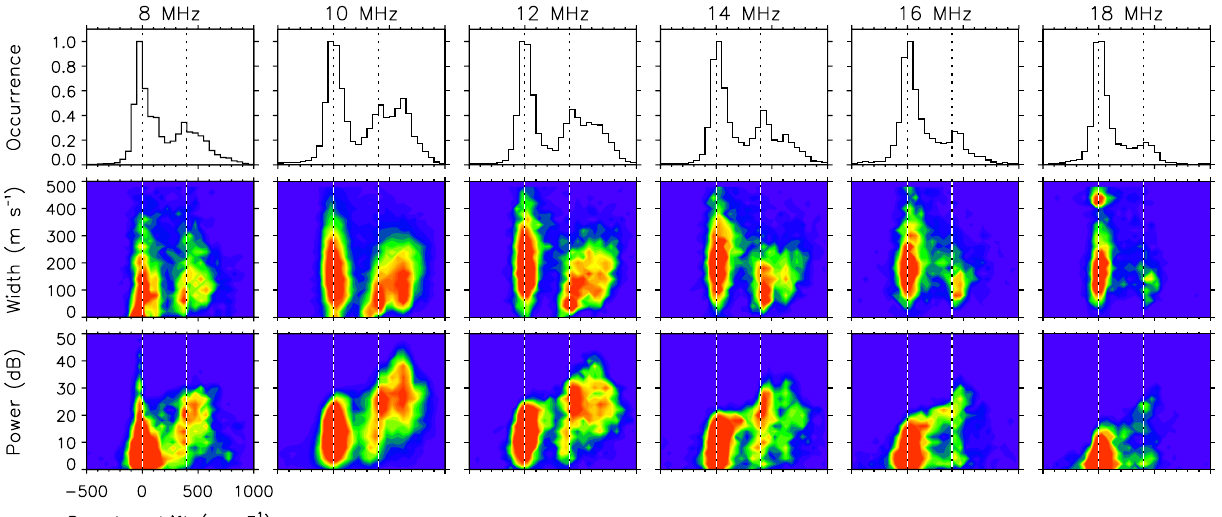
Fig. 6. Echo characteristics in the six frequency bands sounded, for the interval 18:00UT to 20:00UT. (Top panels) Occurrence distributions of Doppler shift. (Middle panels) Occurrence distributions of spectral width versus Doppler shift. (Bottom panels) Occurrence distributions of backscatter power versus Doppler shift. In these distributions, red indicates greatest